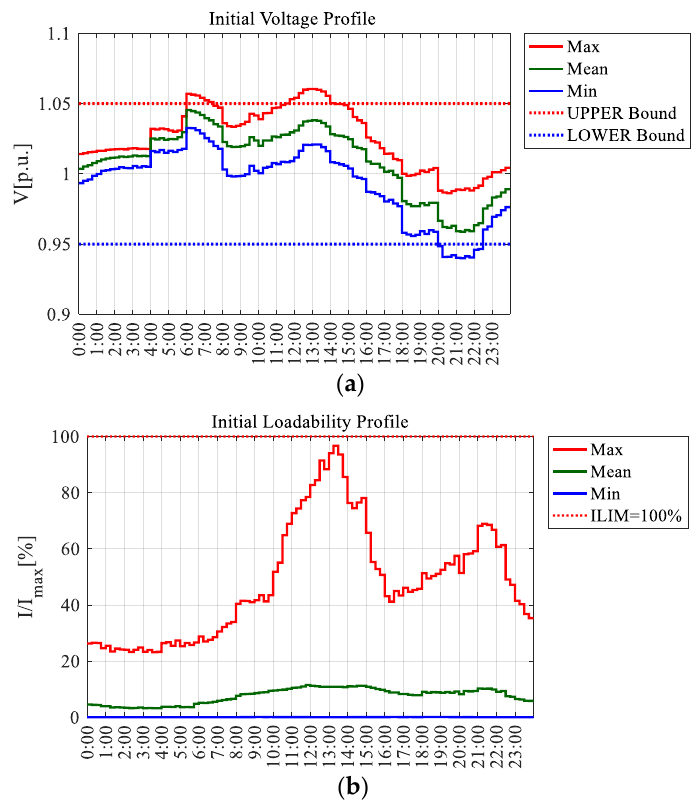
Figure 11. Initial results: ( a ) voltage and ( b ) loadability profiles.